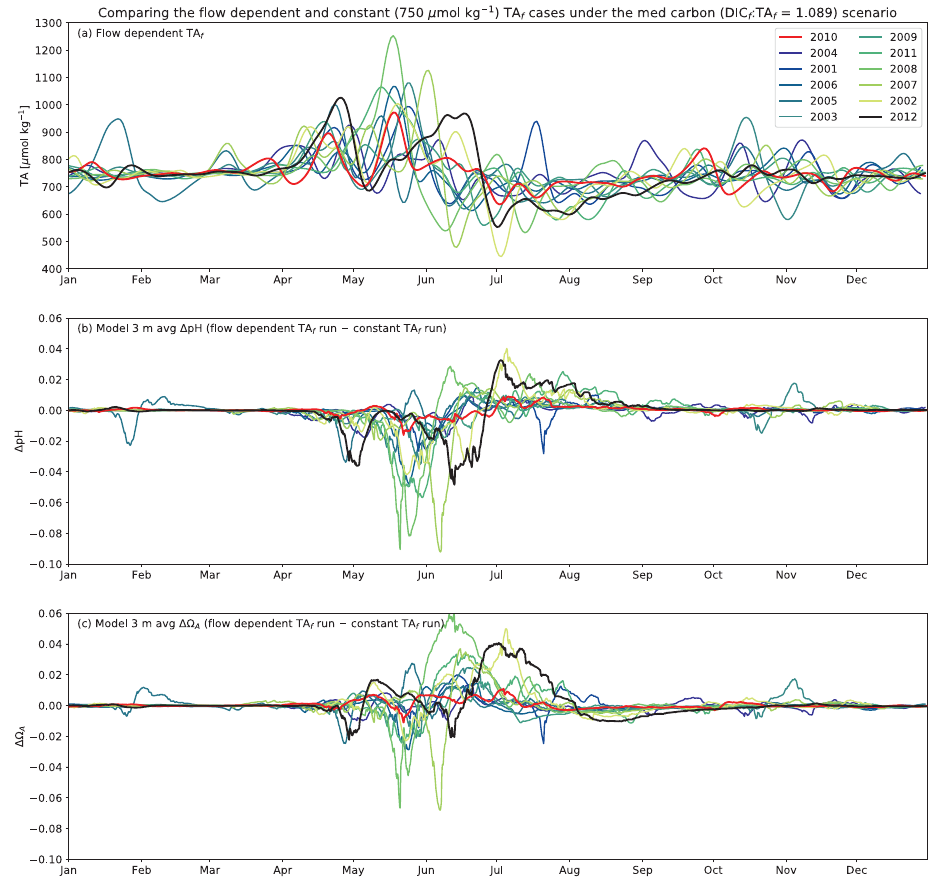
Figure 5. Results of the flow-dependent TA f case for each year in the 12-year record: (a) the flow-dependent TA f parameterization (Eq. 1), and (b, c) differences between flow-dependent and constant (750µmolkg − 1 ) TA f runs at (DIC:TA) f = 1.089 for (b) 3m averaged pH and (c) 3m averaged (cid:127) A . Years of record are plotted in order of increasing freshet size, with the lowest (2010) and highest (2012) years highlighted in red and black, as in Fig. 3. Since flow dependence is proportional to d Q filt / d t , the strongest effects surround the freshet generally with pH and (cid:127) A decreases prior to and increases after the